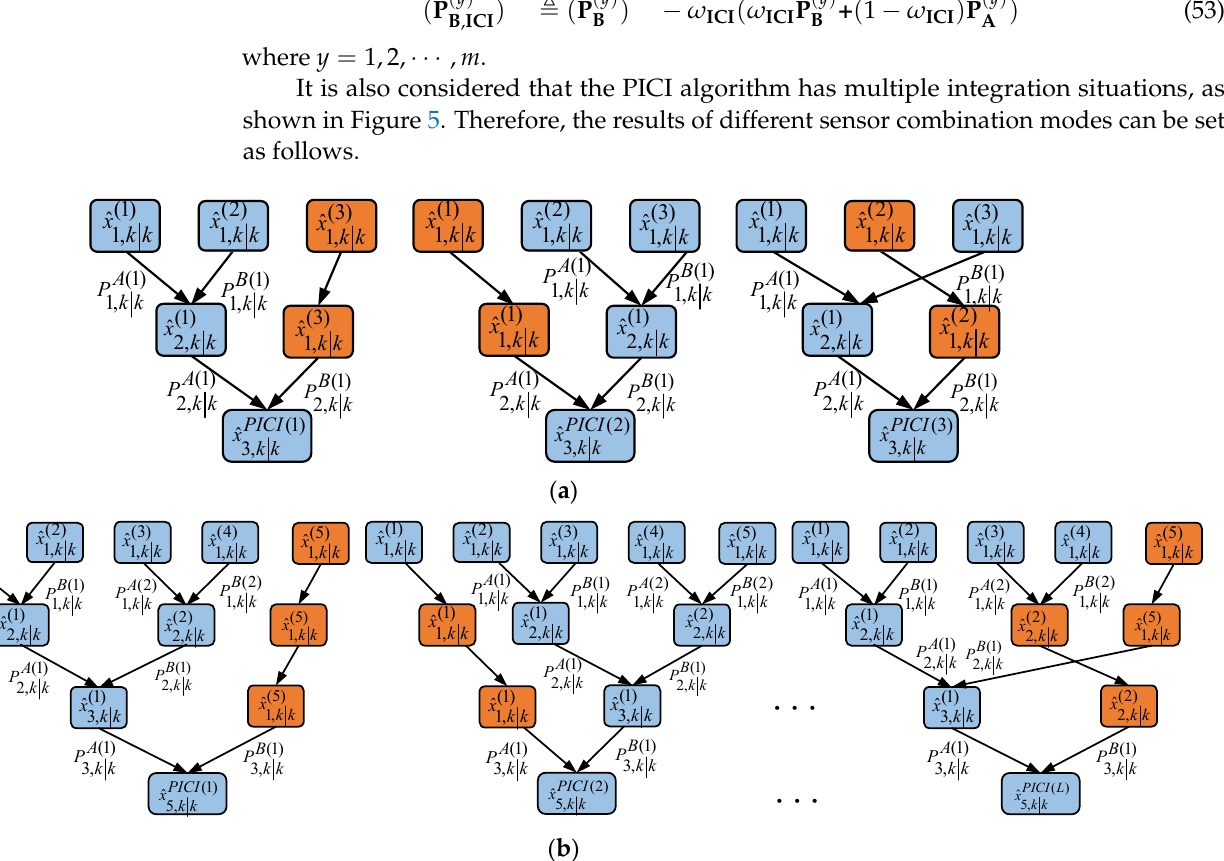
Algorithm 1: PICI-GM-CPHD filtering algorithm flow